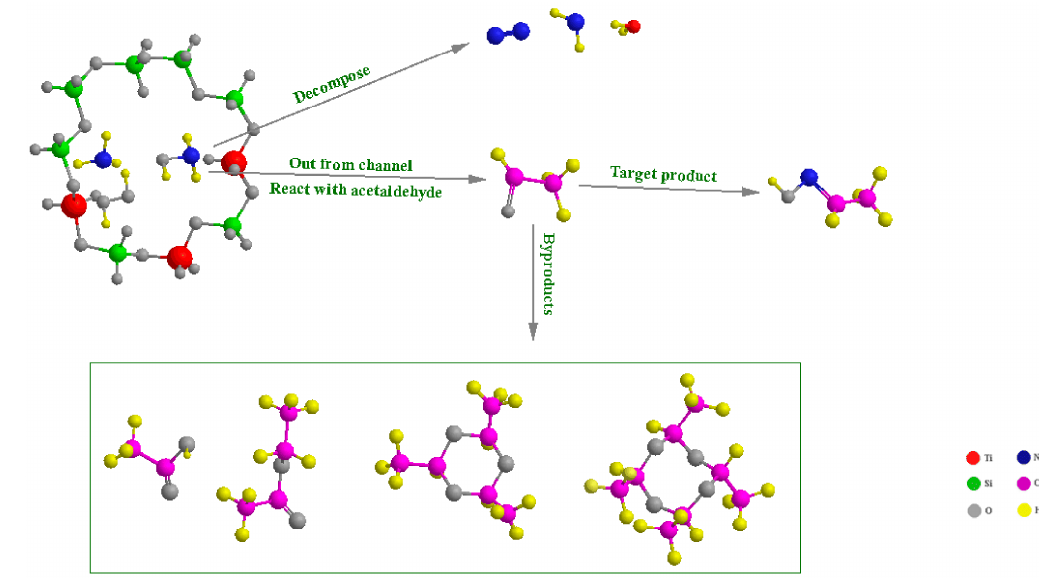
Figure 6. In the TS ‐ 1/H 2 O 2 system, the reaction pathway of acetaldehyde ammoximation to Figure 6. In the TS-1/H 2 O 2 system, the reaction pathway of acetaldehyde ammoximation to acetaldehyde and the byproducts are presented in the experiments. acetaldehyde and the byproducts are presented in the